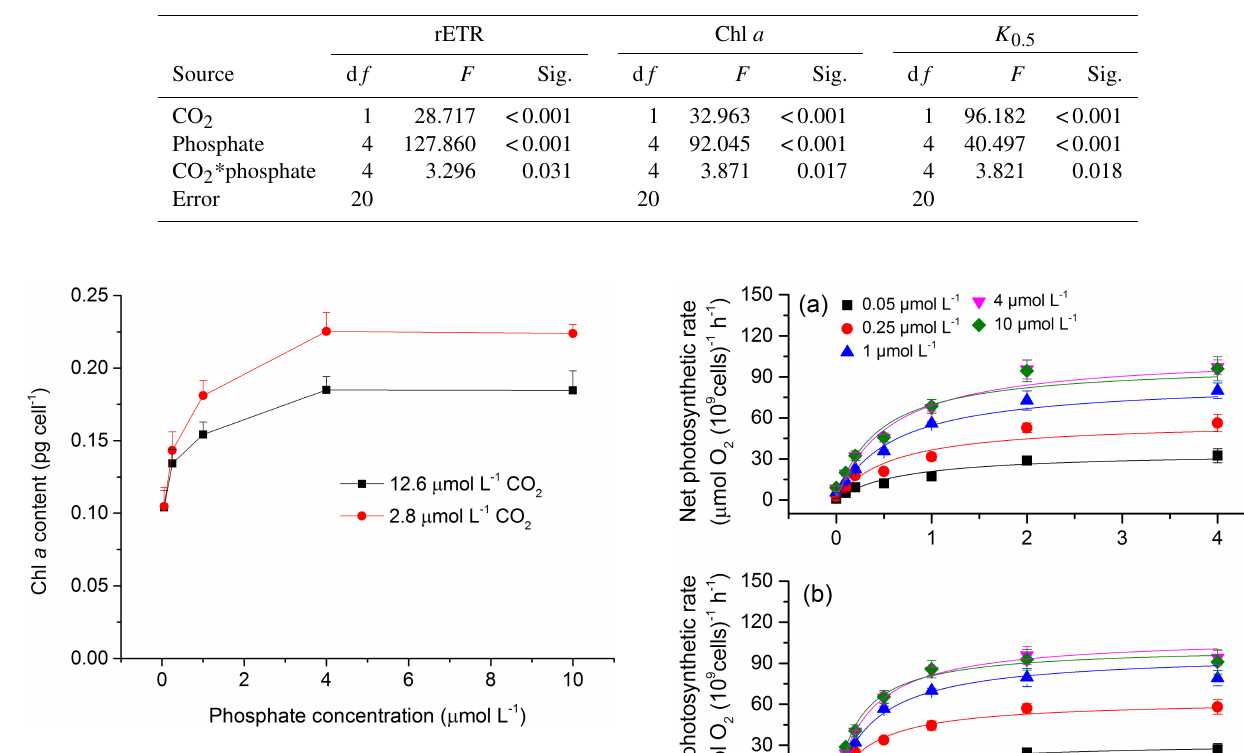
Figure 3. Photosynthetic Chl a content in S. costatum grown at var- ious phosphate concentrations after 12.6 and 2.8µmol CO 2 treat- ments. The error bars indicate the standard deviations ( n = 3).